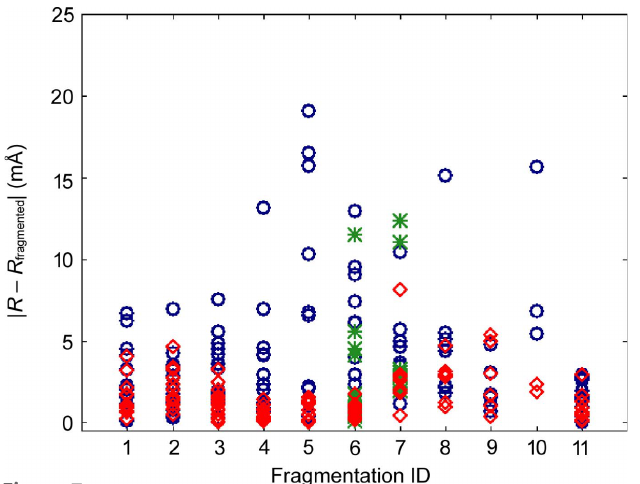
Figure 8 Fragmentation scheme: ( a ) the starting system bond to be broken is marked, ( b ) the system after coarse fragmentation obtained by breaking the bond and adding a capping hydrogen, ( c ) the system with aromatic rings represented as single and double bonds (kekulization was performed), ( d ) the system after fragmentation with the initial fragments extended by at least one neighbour, the aromatic ring was cut along the assigned single bonds in the kekulization